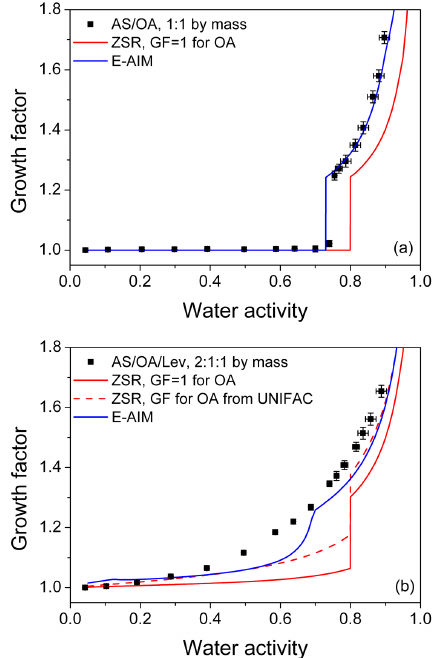
Figure 13. Hygroscopic growth factors of 1:1 AS / OA (a) , 2:1:1 AS / OA / Lev (b) as a function of water activity. Initial particle di- ameter is about 100nm. Predicted growth curves from the ZSR and E-AIM assuming oxalic acid dihydrate are indicated by red and blue lines, respectively. The uncertainty in our measured growth factors is within